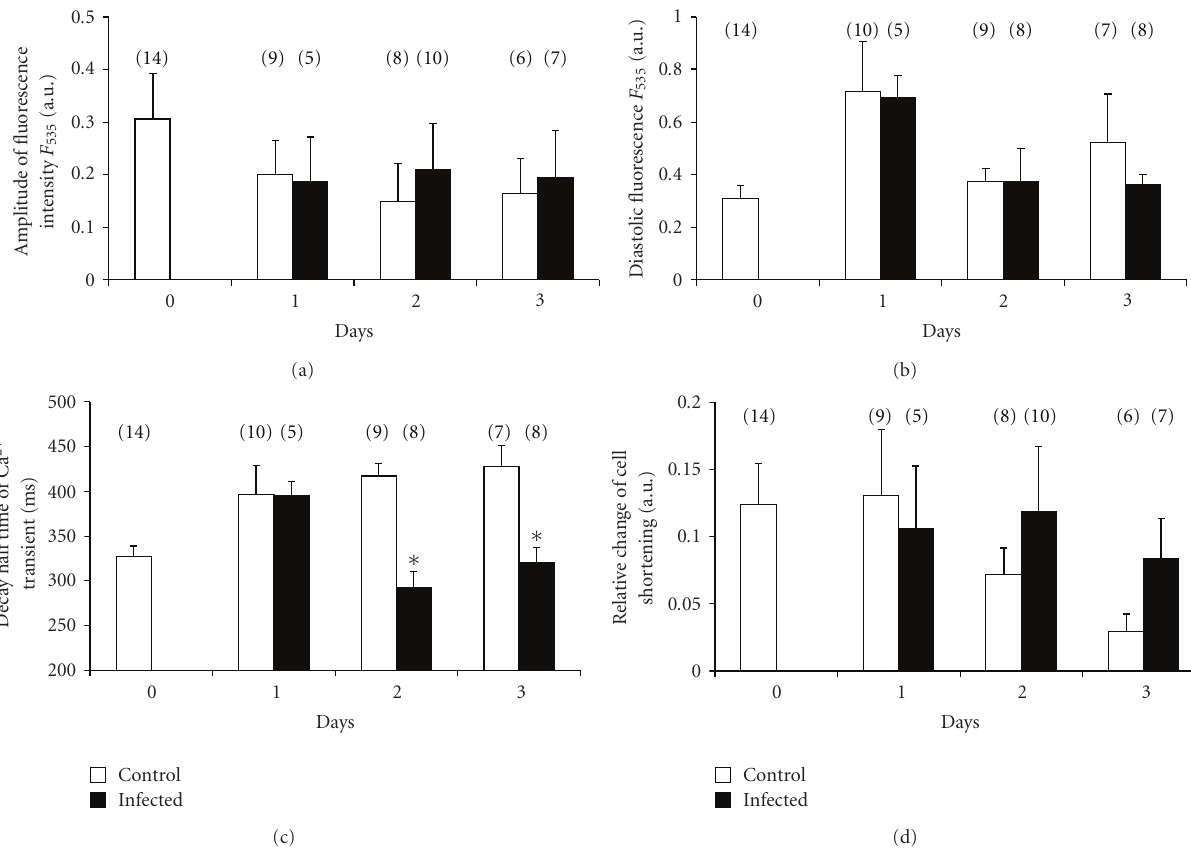
Figure 6: This figure shows several parameters of intracellular free calcium transient such as (a) amplitude of calcium transients, (b) diastolic calcium levels, (c) changes of calcium transient decay constant, and (d) cell-shortening measurements from recordings from control and from virus infected myocytes after 1 to 3 days long culture. Bars represent means ± SEM, and n represents the number of experiments.